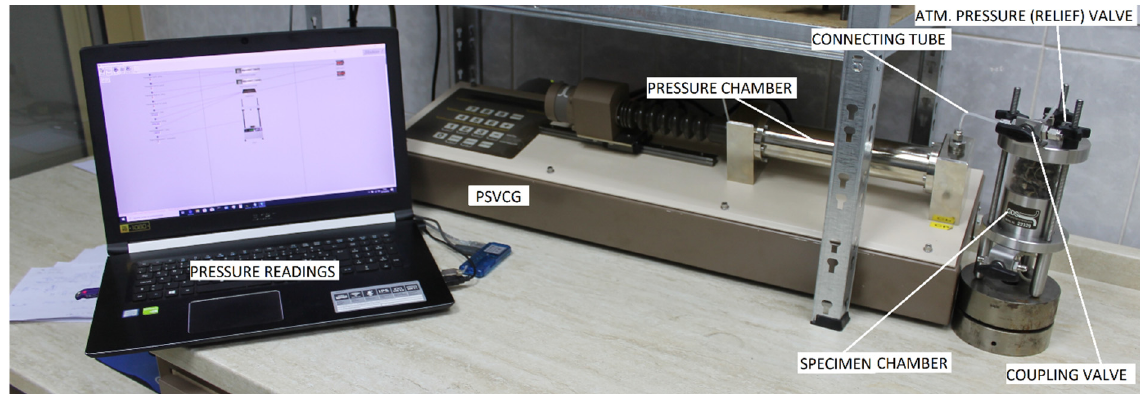
Figure 1. Used air pycnometer setup.